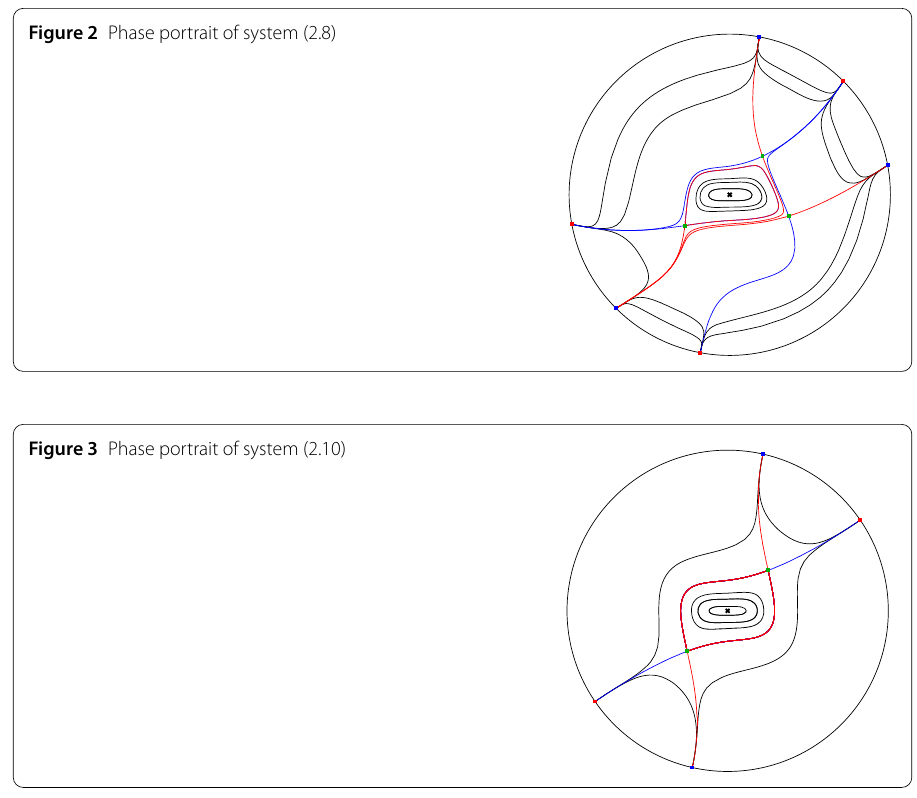
Figure 2 Phase portrait of system (2.8)